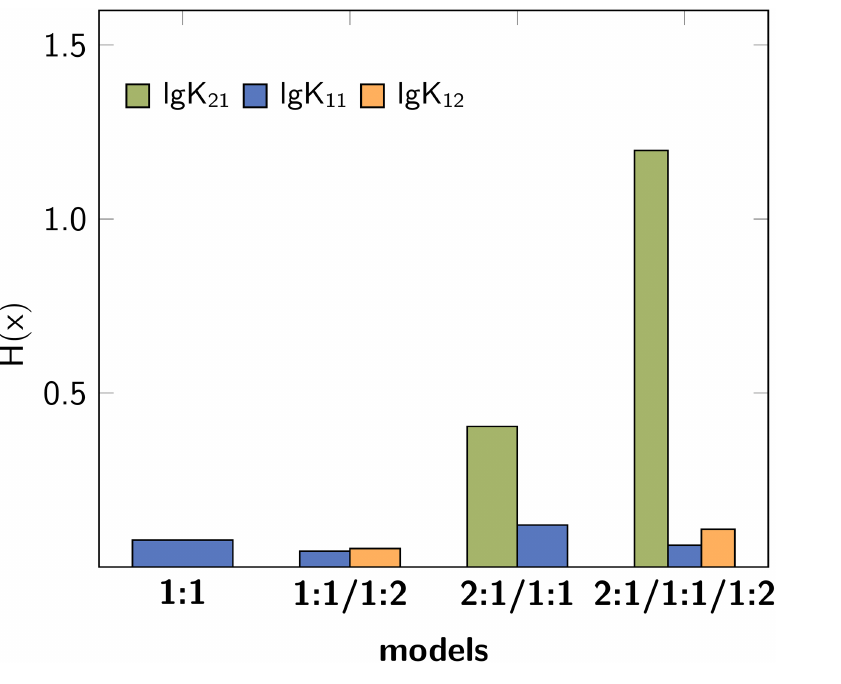
Figure 5 Calculated Shannon entropy after Bootstrapping with S = 2000. Full-size DOI: